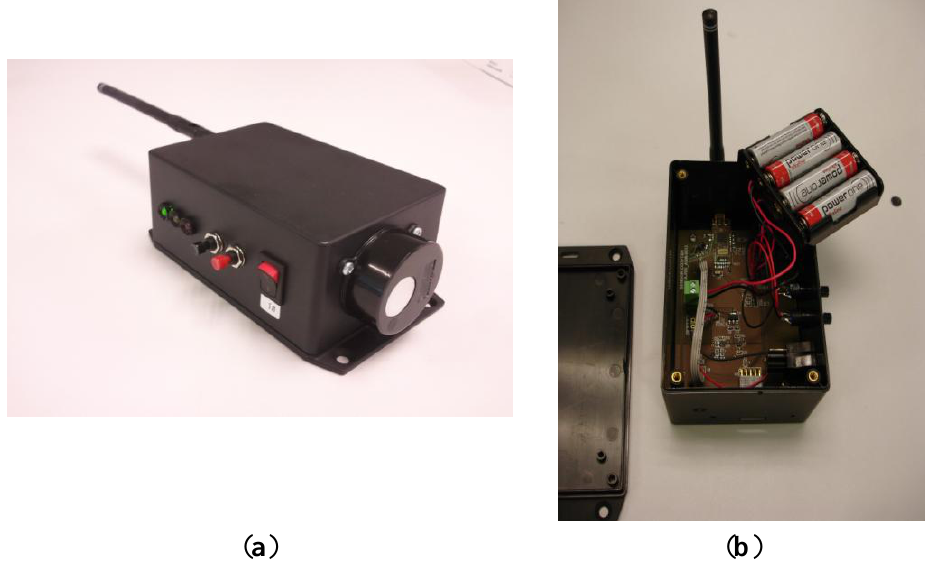
Figure 4. CO Node photographs: ( a ) External view; and ( b ) 2